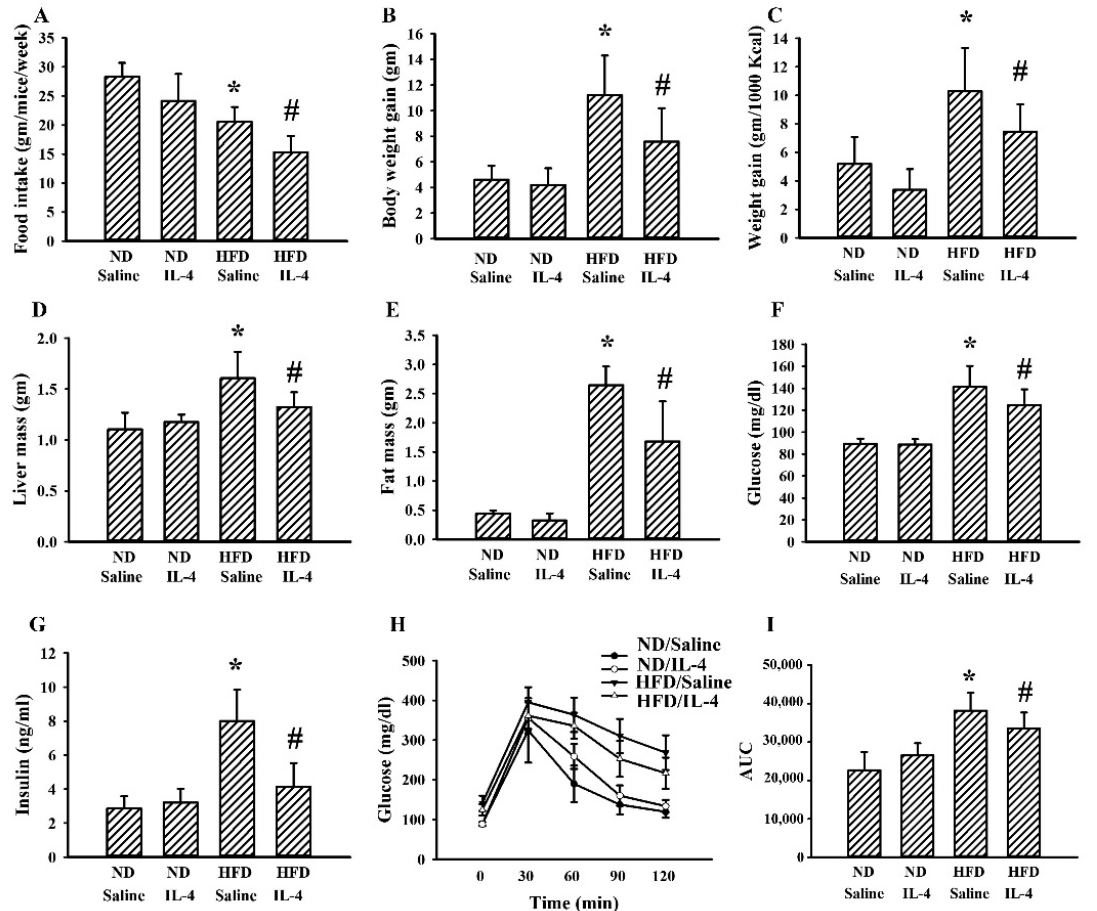
Figure 6. IL‐4 ameliorated metabolic changes in leptin‐resistant mice. C57BL/6 mice were fed the normal diet (ND) or high‐fat diet (HFD) for 12 weeks. Simultaneously, normal saline and IL‐4 (1 μg/mouse) were intraperitoneally administrated twice a week for the last 8 weeks. The average food intake ( A ), body weight gain ( B ), feeding efficacy ( C ), liver mass ( D ), and epididymal fat mass ( E ) were measured. Blood samples were collected from 8‐h fasting mice and fasting glucose ( F ) and insulin ( G ) levels measured. The 8‐h fasting mice were intraperitoneally injected with a glucose solution (2 g/kg). Blood samples were collected from the tail veins at the indicated times after treatments and levels of glucose measured ( H ). AUC of the glucose–time curves was calculated ( I ). * p < 0.05 vs. ND/saline group and # p < 0.05 vs. HFD/saline group, n = 6.